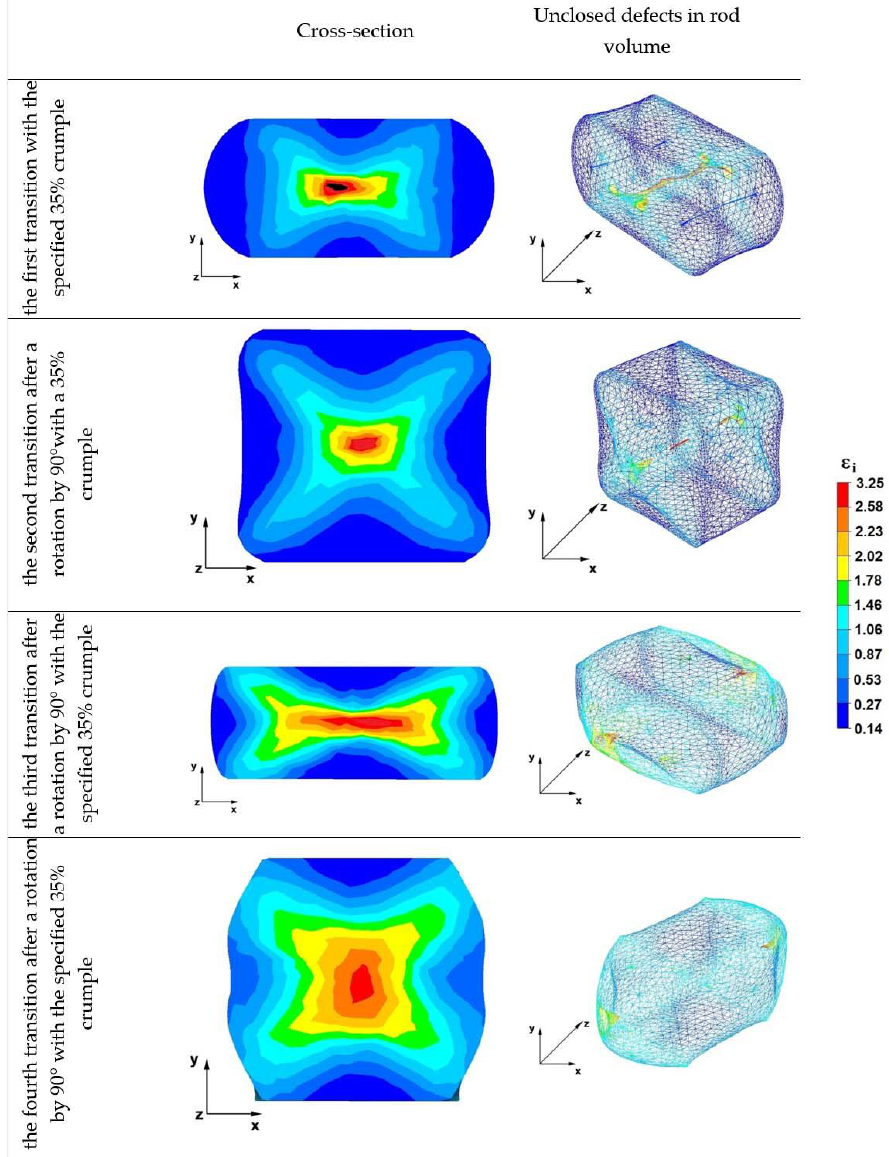
Figure 13. Effective strain distribution in flat anvils.